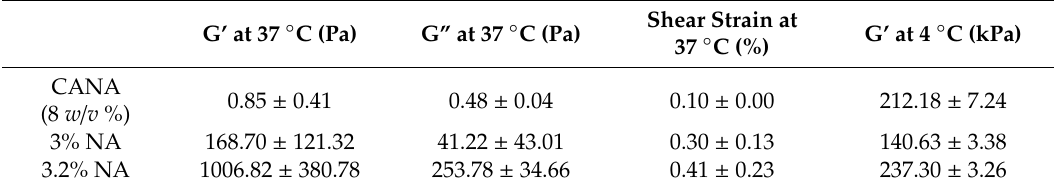
Table 1. Comparison of the moduli and shear strain of di ff erent formulations in the sol state at 37 ◦ C and in the gel state at 4 ◦ C (n = 3).